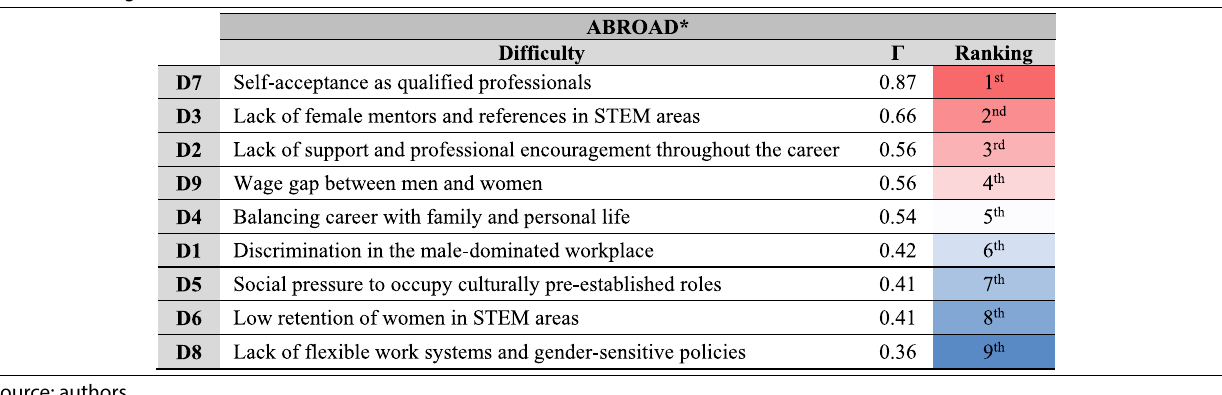
Table 8 Ranking of difficulties